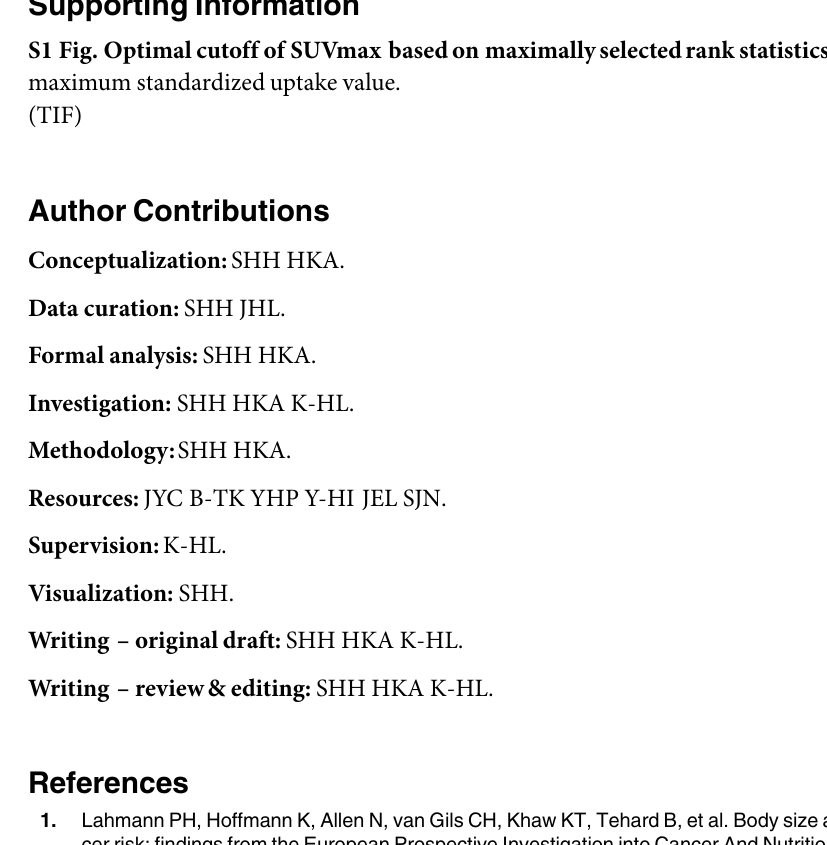
S1 Fig. Optimal cutoff of SUVmax based on maximallyselectedrank statistics. SUVmax, maximum standardized uptake